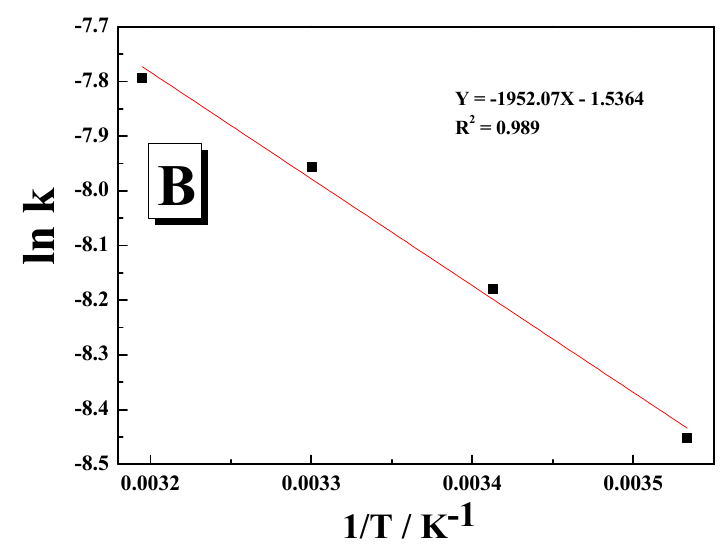
Figure 7. The thermal fading kinetics of: ( A ) Sn(II)-chelated R–PLG 23 metal complexes after UV irradiation for different temperatures ([SnCl 2 ] = 10 − 3 M, and [R–PLG 23 ] = 10 − 4 M in THF). Inset: The curves fitted with first-order reaction dynamics ln A = − kt to calculate the thermal bleaching speed constant: k = 2.13 × 10 − 4 s − 1 (10 ◦ C), k = 2.99 × 10 − 4 s − 1 (20 ◦ C), k = 3.01 × 10 − 4 s − 1 (27 ◦ C), k = 3.64 × 10 − 4 s − 1 (30 ◦ C), k = 4.12 × 10 − 4 s − 1 (40 ◦ C). ( B ) The data were fitted with Arrhenius expressions.